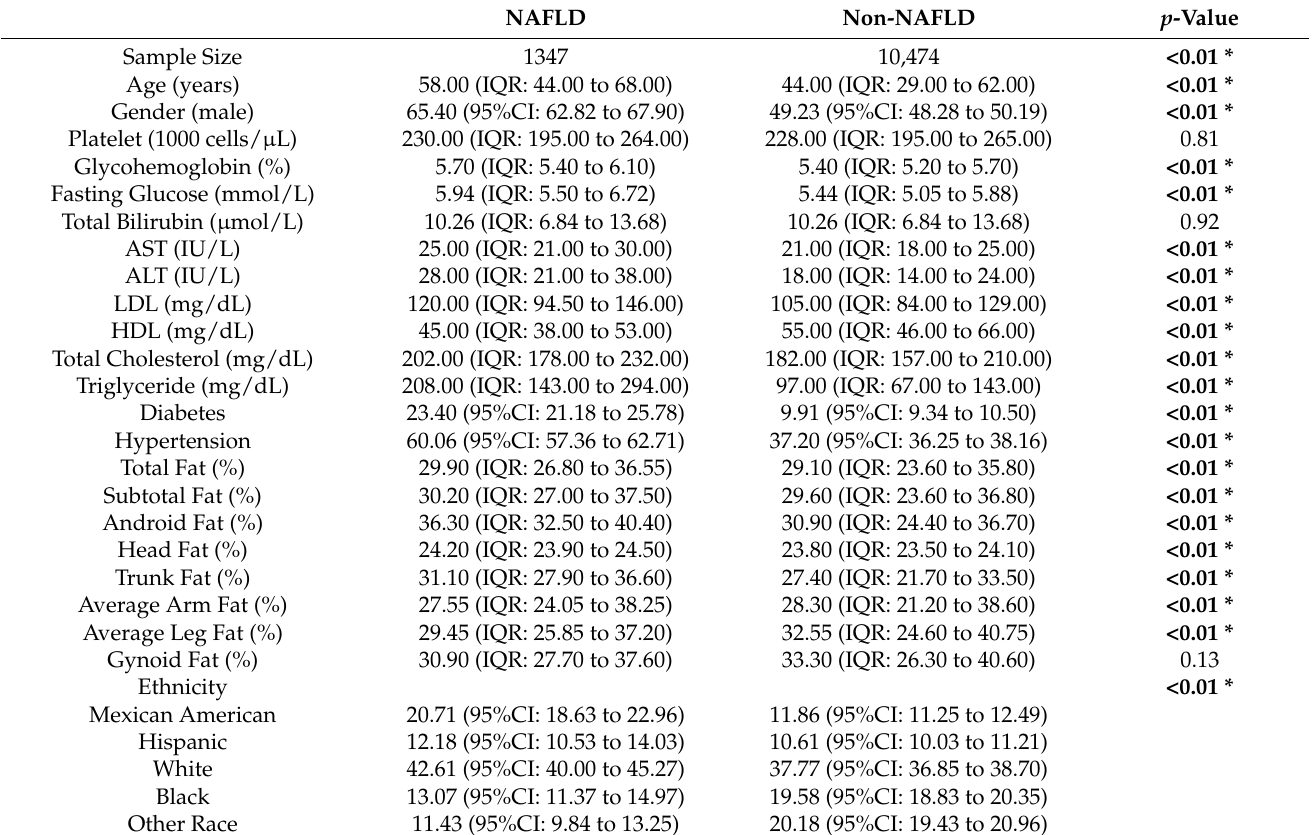
Table 1. Baseline Demographics of NAFLD and Non-NAFLD Patients in Non-obese Population. NAFLD Non-NAFLD p